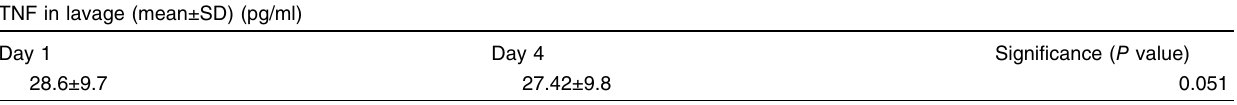
Table 12 Comparison between days 1 and 4 regarding TNF α in group I using the Wilcoxon signed-rank test TNF in lavage (mean±SD) (pg/ml)